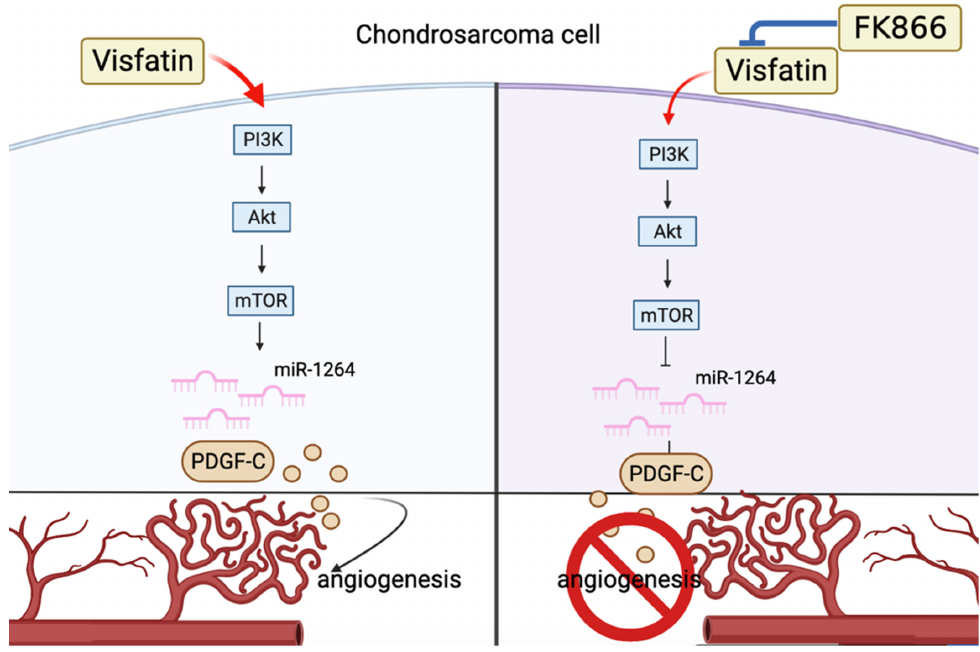
Figure 7. Schematic diagram of visfatin-induced increases in PDGF-C expression and EPC angiogen- esis in chondrosarcoma cells. Visfatin downregulated miR-1264 via a PI3K/Akt/mTOR-dependent pathway to promote the production of PDGF-C and subsequently induce EPC